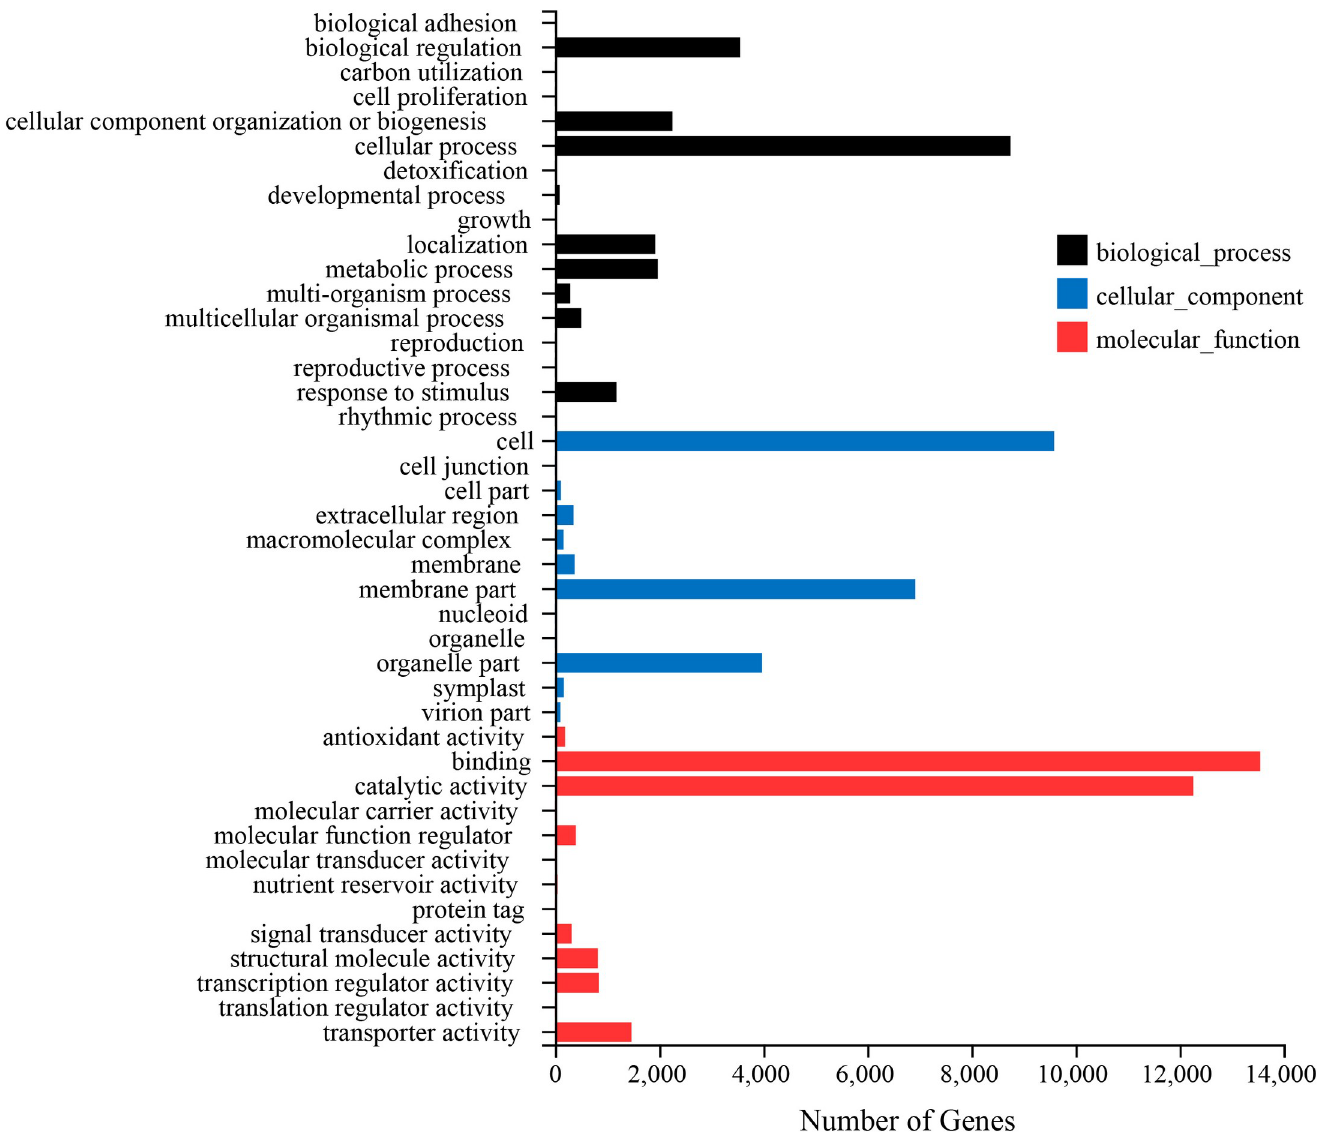
Fig 4. Functional annotations and classifications of unigenes in GO databases. GO analysis was performed at level 2 for the three main categories (biological process, cellular component and molecular function).